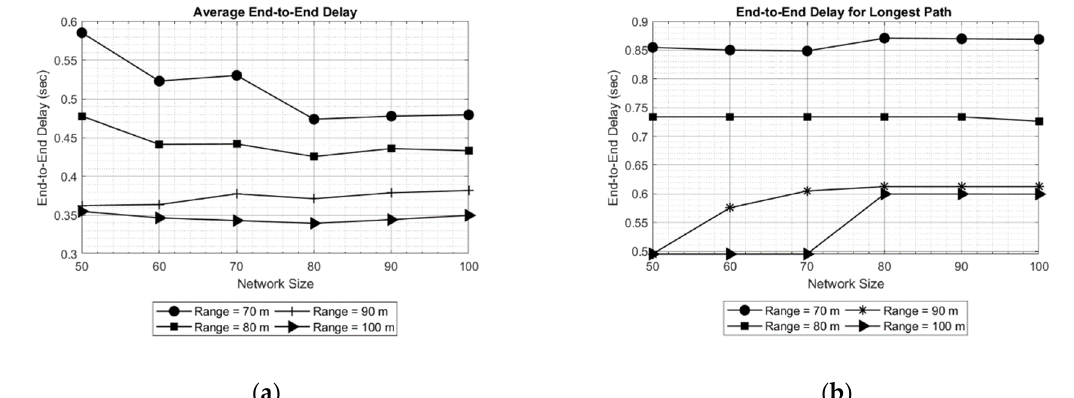
Figure 18. Average end-to-end delay ( a ) and end-to-end delay for longest path ( b ).